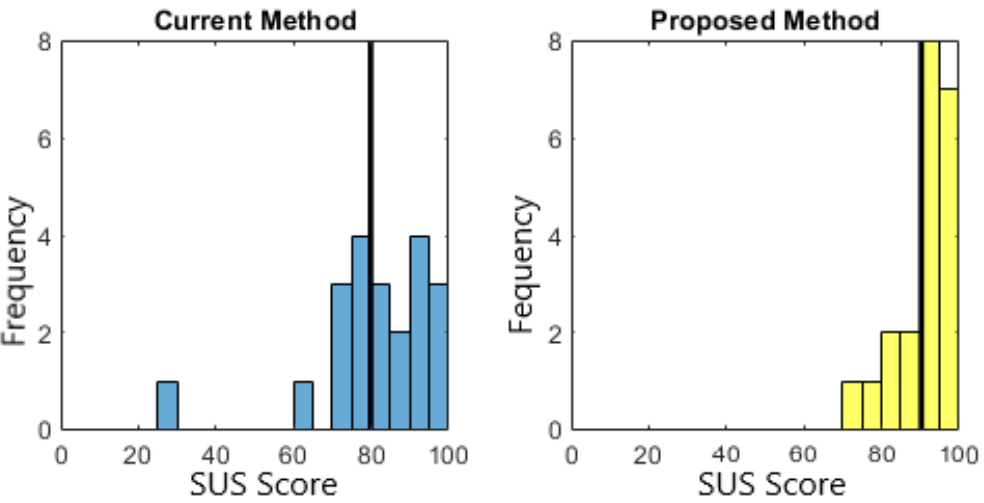
Figure 7. Distributions of SUS scores. Blue represents the original system and Yellow the proposed one. Black lines mark the average value of both